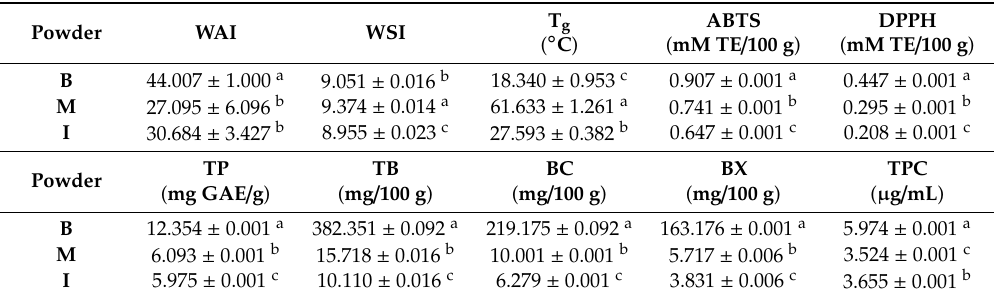
Figure 1. Freeze-dried beet powders: ( a ) pure beet powder; ( b ) maltodextrin encapsulated beet powder; ( c ) beet powder encapsulated with inulin. Table 1. Physicochemical characterization of lyophilized extracts of beet ( Beta vulgaris sp.) (Mean ± Standard Error).